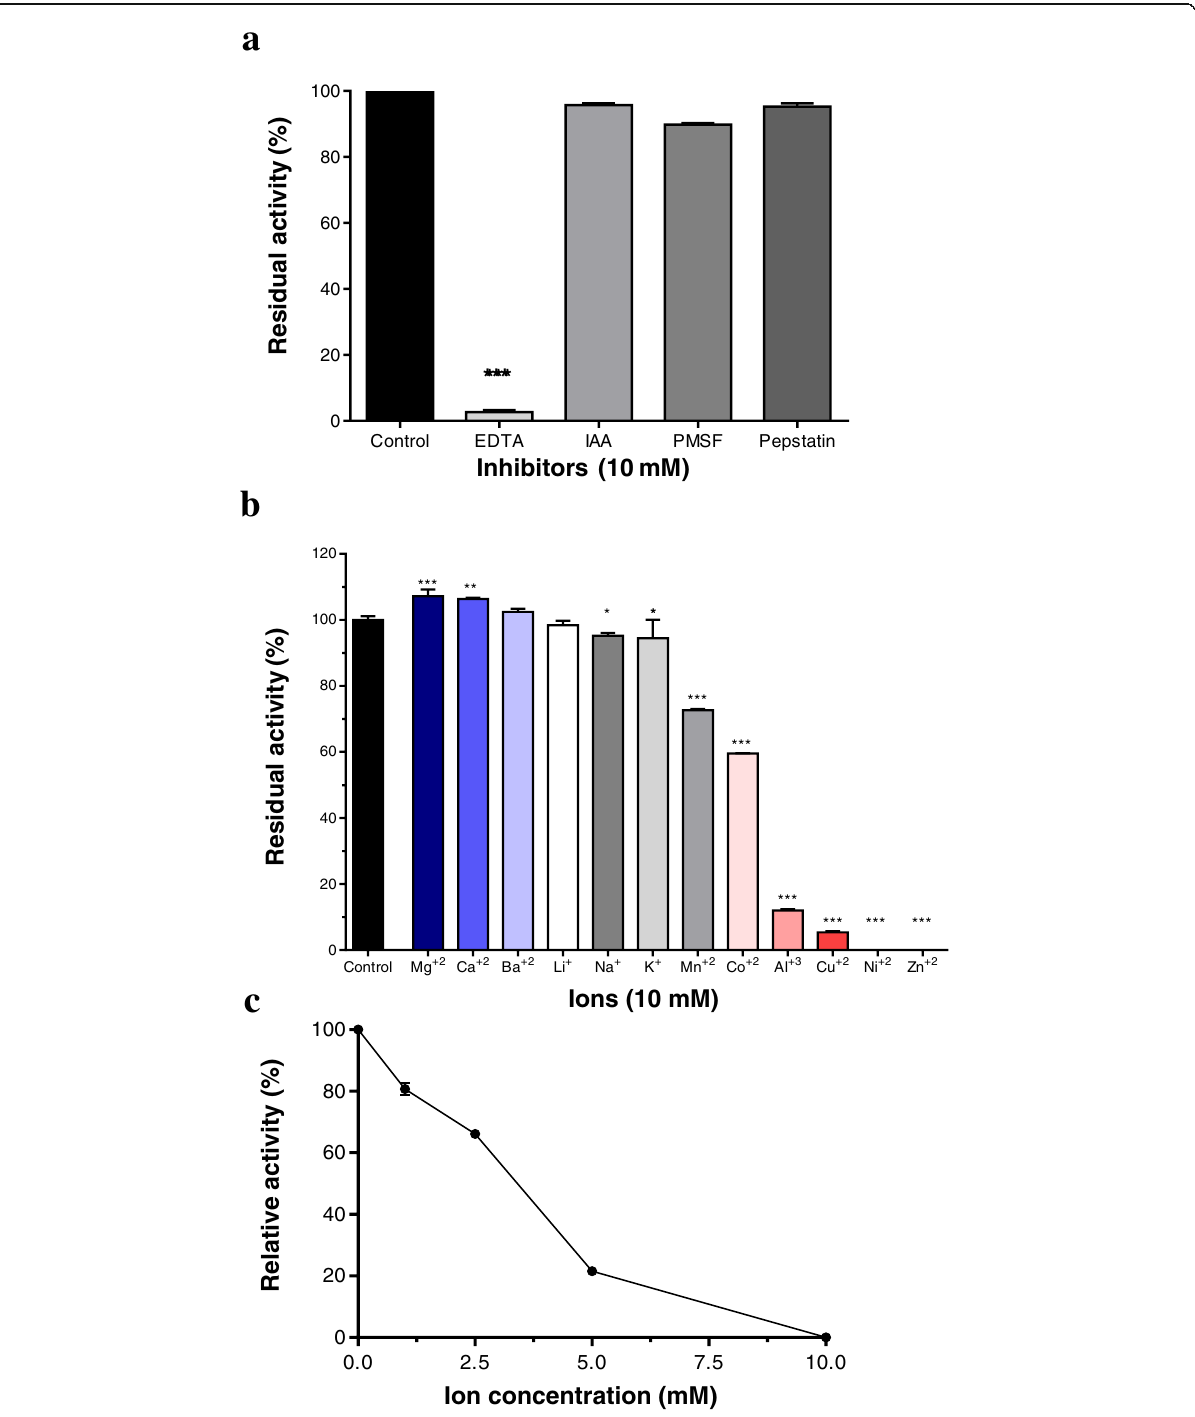
Fig. 3 Enzymatic activity of Lmr-MP upon inhibitors and different ions. a Azocaseinolytic activity of Lmr-MP (10 μ g/100 μ L): in the absence (control) or presence of 10 mM different inhibitors (EDTA, IAA, PEPS and PMSF). b in the presence of 10 mM different ions (CoCl 2 , LiCl, MgCl 2 , KCl, ZnCl 2 , NiSO 4 , CuCl 2 , CaCl 2 , MnCl 2 , AlCl 3 , BaCl 2 and NaCl). c in the presence of ZnCl 2 at different concentrations (2.5, 5.0, 7.5 and 10 mM). The reactions were performed at 37 °C. The residual activity was determined based on control activity: Residual activity = 100 x [(Sample activity)/ (Control activity)]. * p < 0.05, ** p < 0.01 and *** p < 0.0001 compared to the controls (one-way ANOVA, followed by Dunnett ’ s test). Data ( n = 3) are presented as mean ±